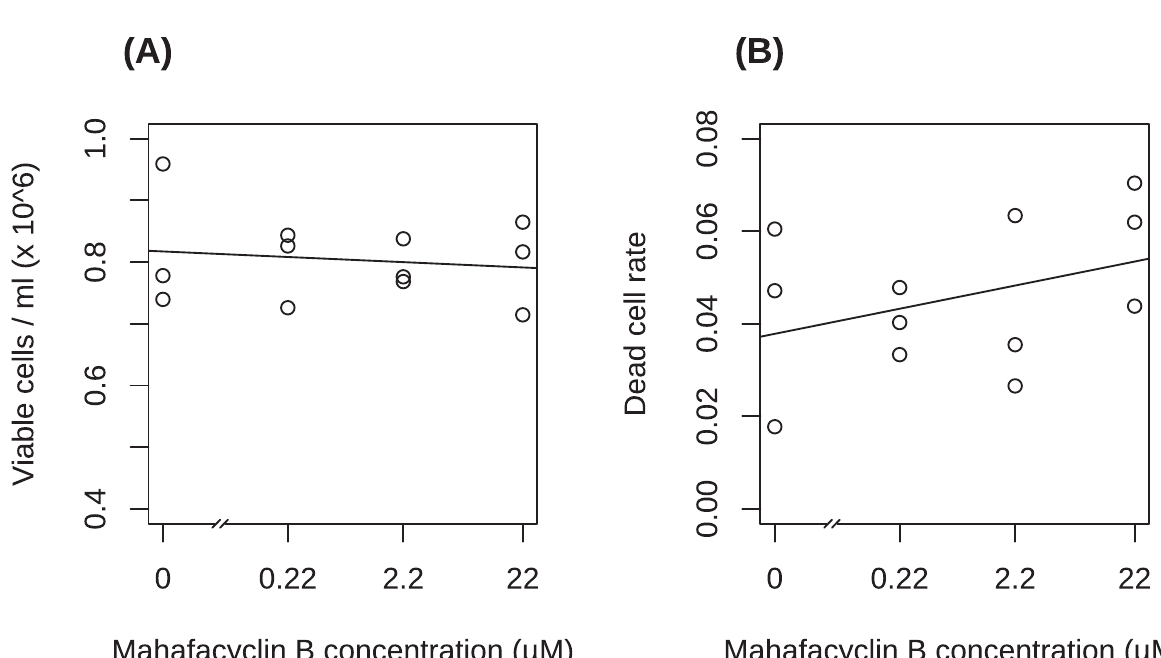
Fig 2. Mahafacyclin B does not affect proliferation of CHO-K1 cells. (A) Scatter plot of drug concentration vs . density of viable cells. (B) Scatter plot of drug concentration vs . dead cell rate. Cells were exposedto vehicleor mahafacyclin B for 10 h, and proliferation and viabilitywere assessed using a cell counter and Trypan Blue.